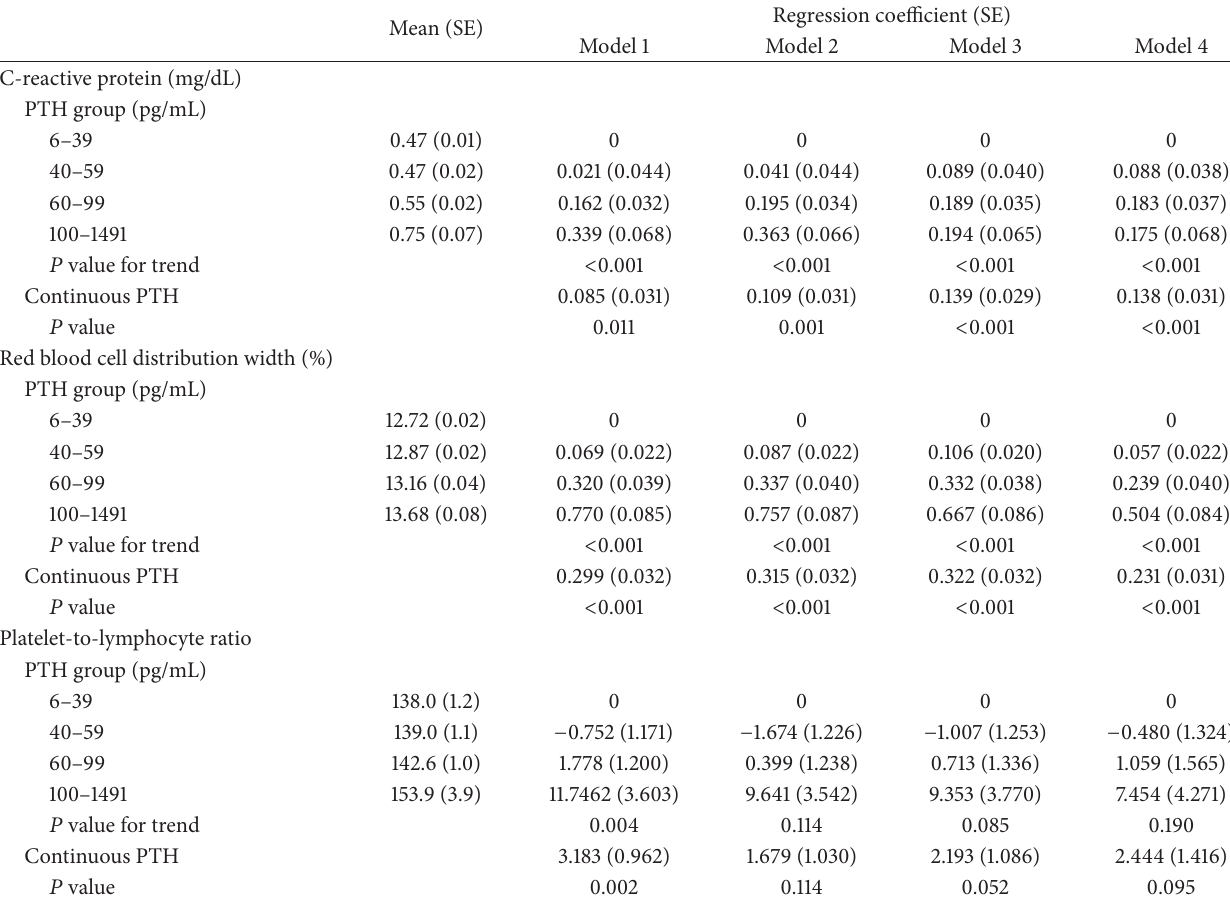
Table 2: Weighted mean values and the regression coefficients with standard errors (SEs) for C-reactive protein, red blood cell distribution width, and platelet-to-lymphocyte ratio by serum parathyroid hormone (PTH) levels among the United States adults aged at least 20